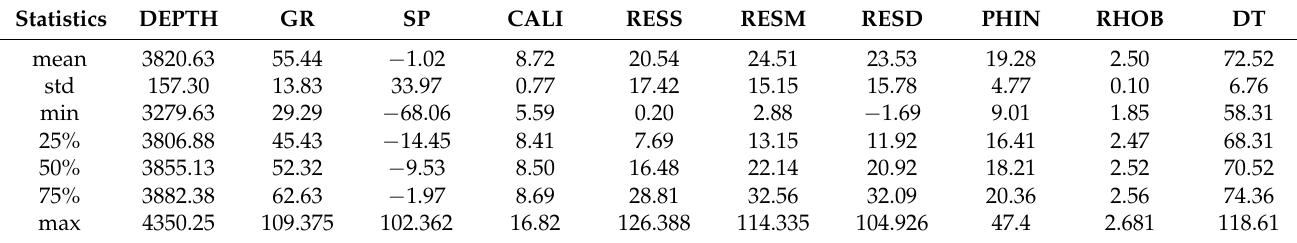
Table 1. The description of the well-logging